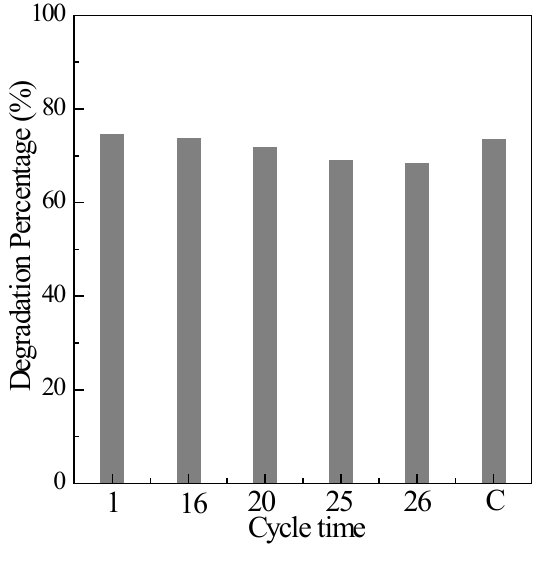
/Ni film with consecutive runs under 2 = 40mg/L, and the 0 /Ni 2